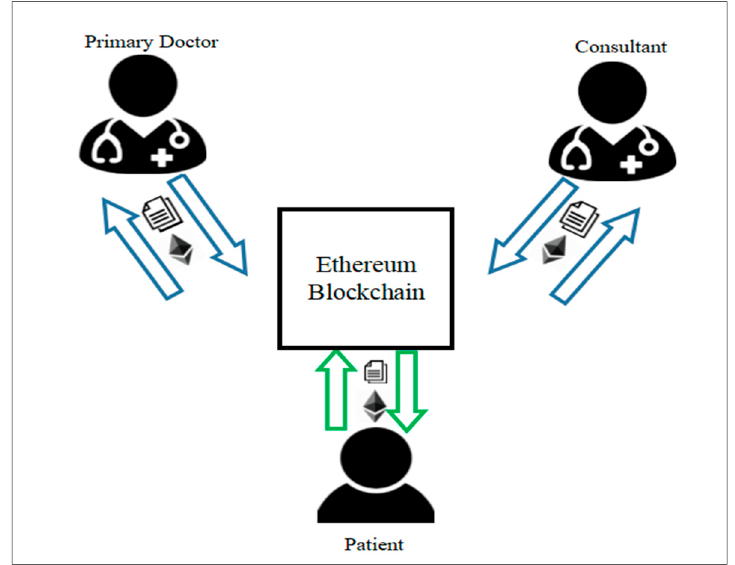
Figure 5. Smart contract for enabling communication between patient and service provider.